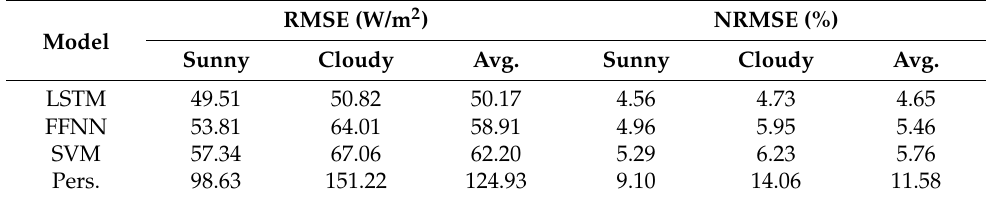
Table 7. Results for the proposed and other models with two parameters clustering for Golden.